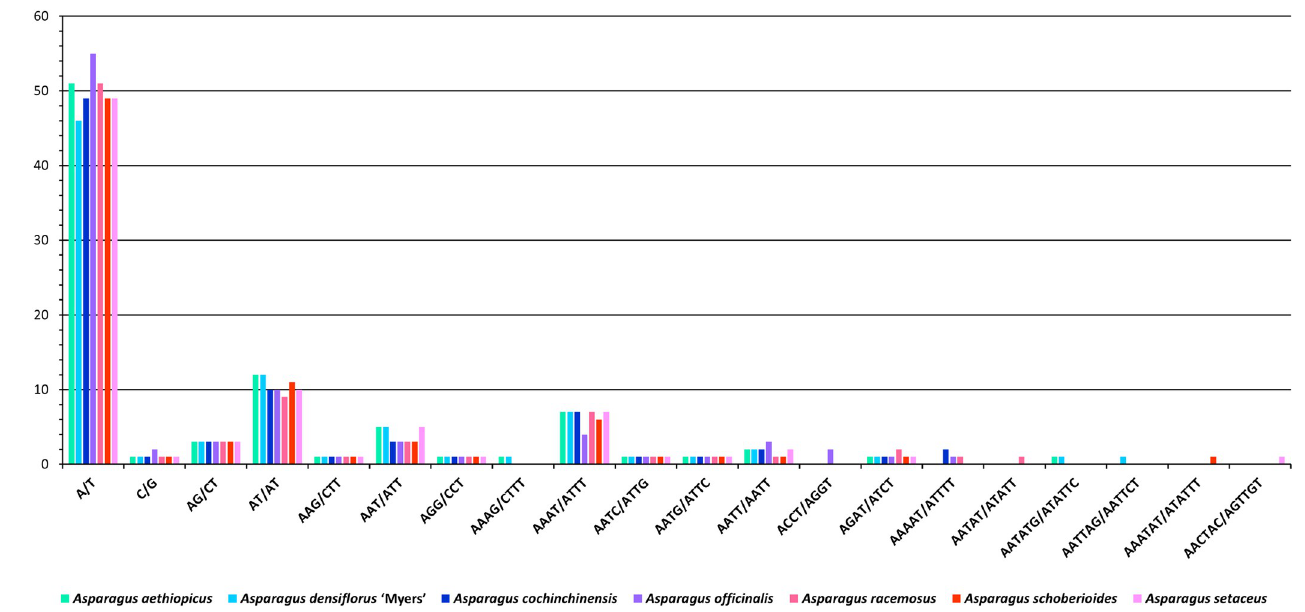
Fig 4. Simple sequence repeat frequency related to sequence complementarity. https://doi.org/10.1371/journal.pone.0266376.g004 Fig 7 represents their frequencies in three intervals: (i) 30–39 bp, (ii) 40–49 bp, and (iii) 50–56 bp. LSRs of 30–39 bp and 50–56 bp occurred in all three species, whereas only A . densiflorus ‘Myers’ has LSRs of 40–49 bp (six, in total). LSRs of 30–39 bp were the most common, with 39